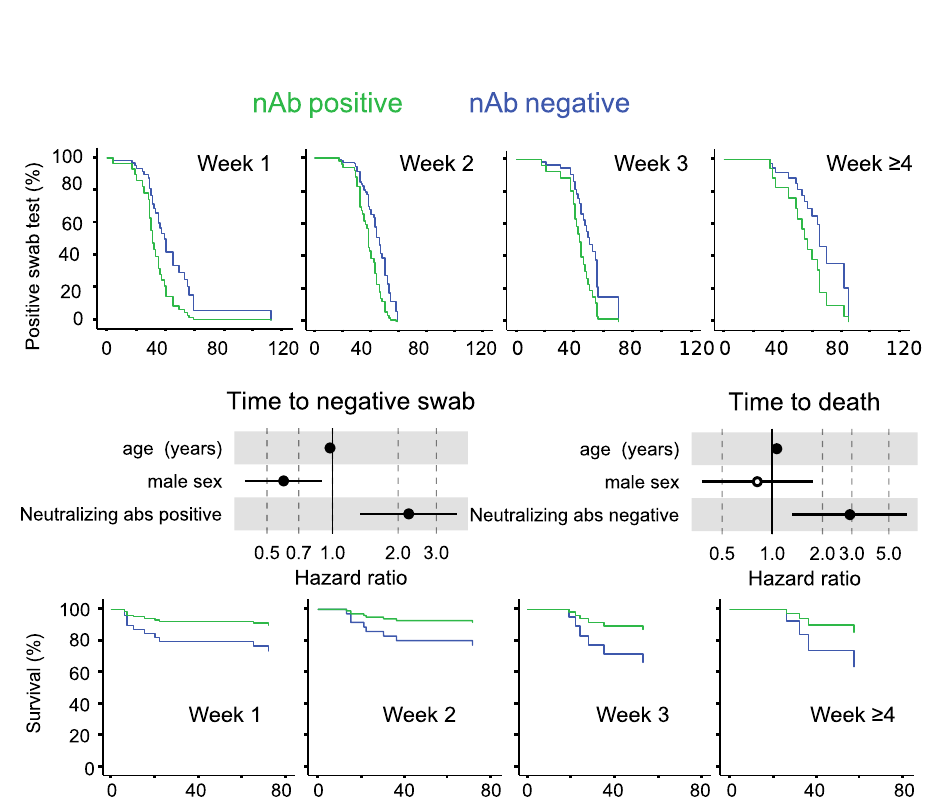
Fig. 4 Early development of the nAb response correlates with viral control and survival. Cox regression survival estimates for 150 patients with COVID- 19 sampled for nAb response to SARS-CoV-2 during in-hospital visit. The analysis was adjusted for sex and age and strati fi ed for the time from symptoms onset at serum sampling. In ( a ) the time to a SARS-CoV-2 negative naso-pharyngeal swab (HR 2.238, 95%CI 1.342 – 3.734; p = 0.002) and in ( b ) the survival rate (HR 2.918, 95%CI 1.321 – 6.449; p = 0.008) was estimated by the presence or absence of a nAb response. Dots represent the Hazard Ratio (HR), fi lled dots stand for p < 0.05 (two-sided). Wald statistics were used for comparison. Source data are provided as a Source Data